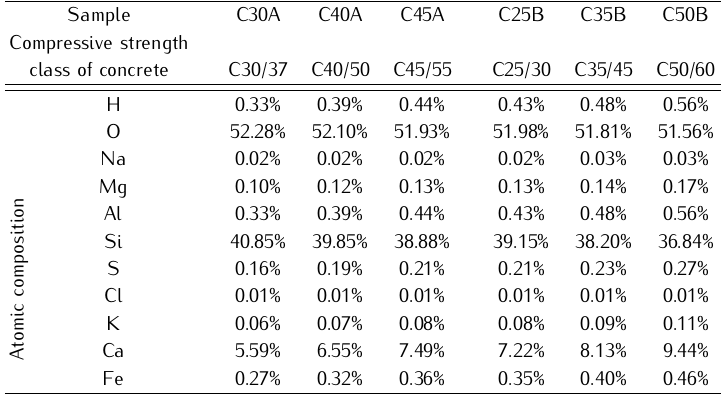
Table 5. Concrete atomic compositions of different compressive strength class for SPOT simulations.